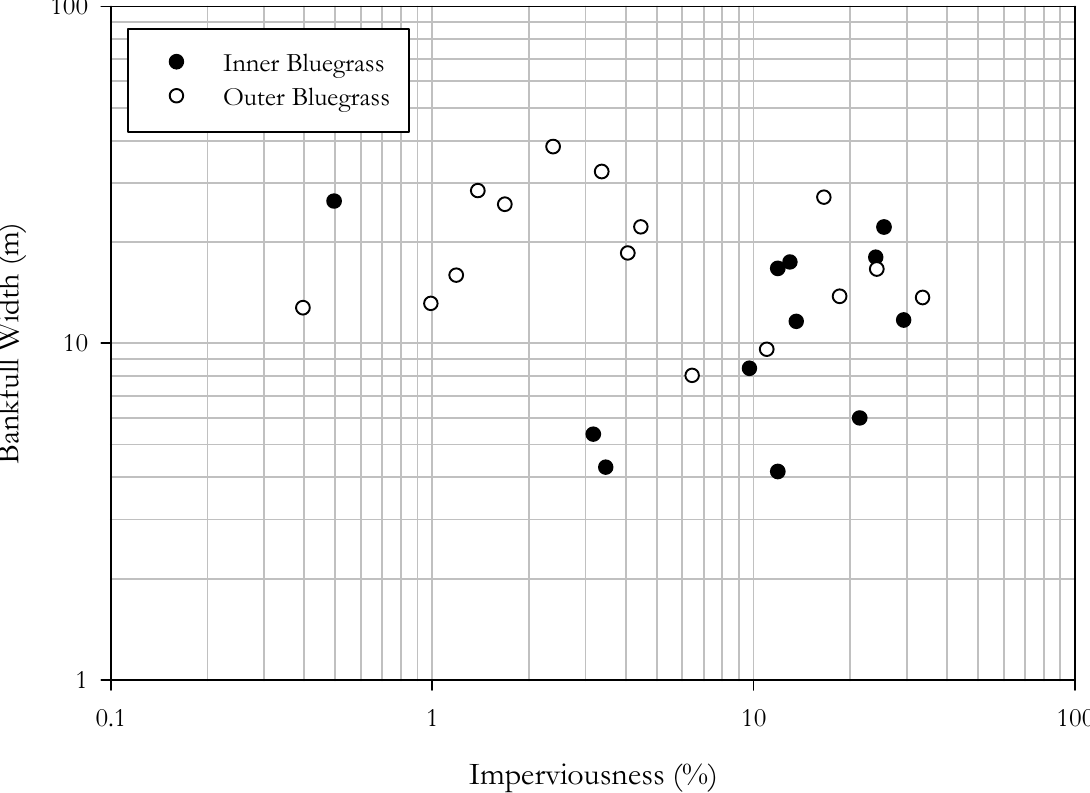
Figure 10. Imperviousness vs . bankfull width for the Inner Bluegrass and Outer Bluegrass